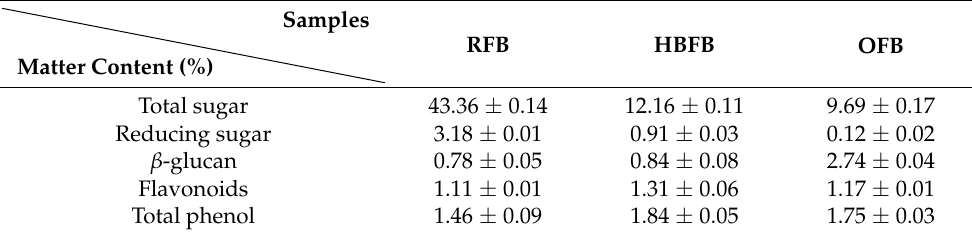
Table 5. Contents of total and reduction sugars and phenolic compounds analyzed by spectrophoto- metric methods by RFB, HBFB, OFB.